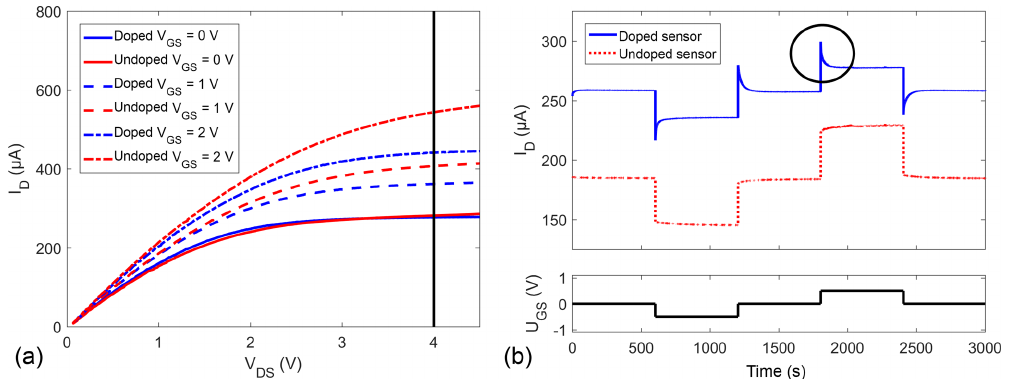
Figure 3. (a) IV curves at different gate biases for doped and undoped sensors with indication of the measurement set point of V DS = 4V and (b) drain current I D at different gate biases for doped and undoped samples annealed in situ with a circle exemplarily highlighting one overshoot for the doped sensor. The different gate potentials − 0 . 5, 0, and + 0 . 5V are shown in the lower subplot. The measurements in (a) and (b) were done some time apart, so that the slight baseline shift can be explained by sensor drift.